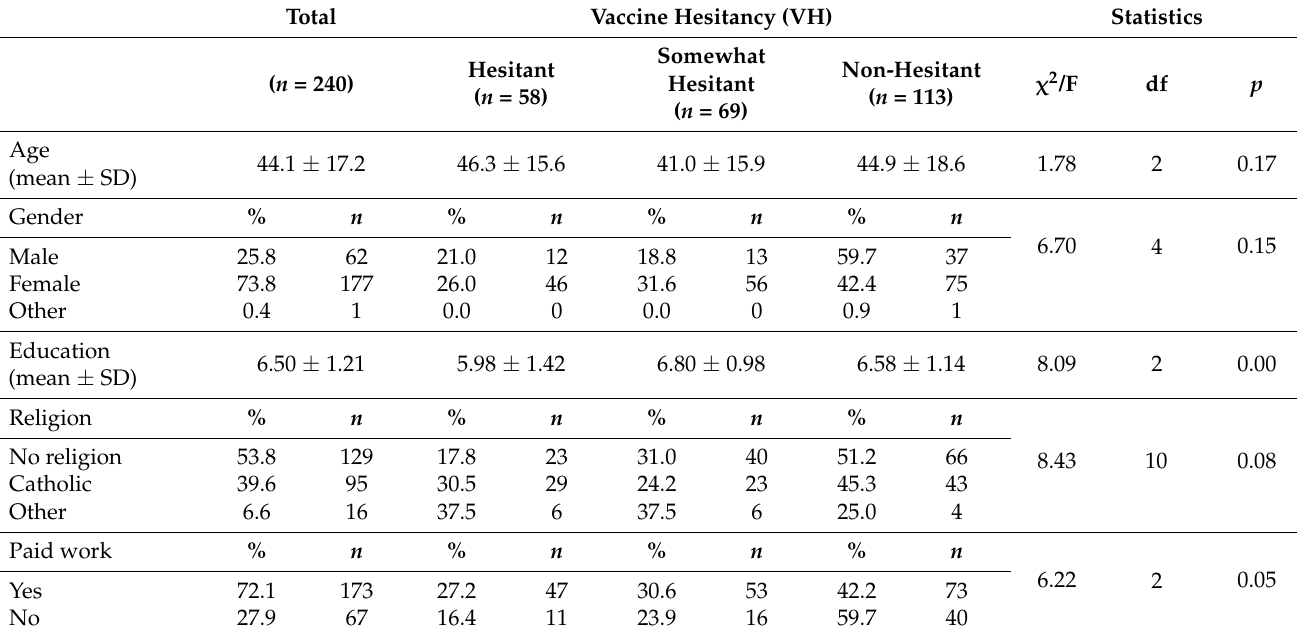
Table 1. Between-Group Comparison for Predisposing